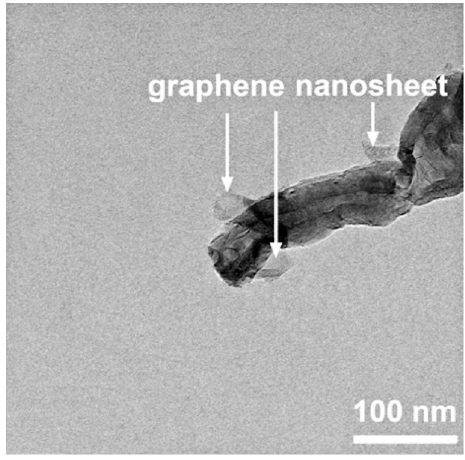
Figure 12. TEM image of graphene nanosheet formed during spark plasma sintering at 2000 °C [123]. (Adapted with permission from [123], Elsevier, 2013.)